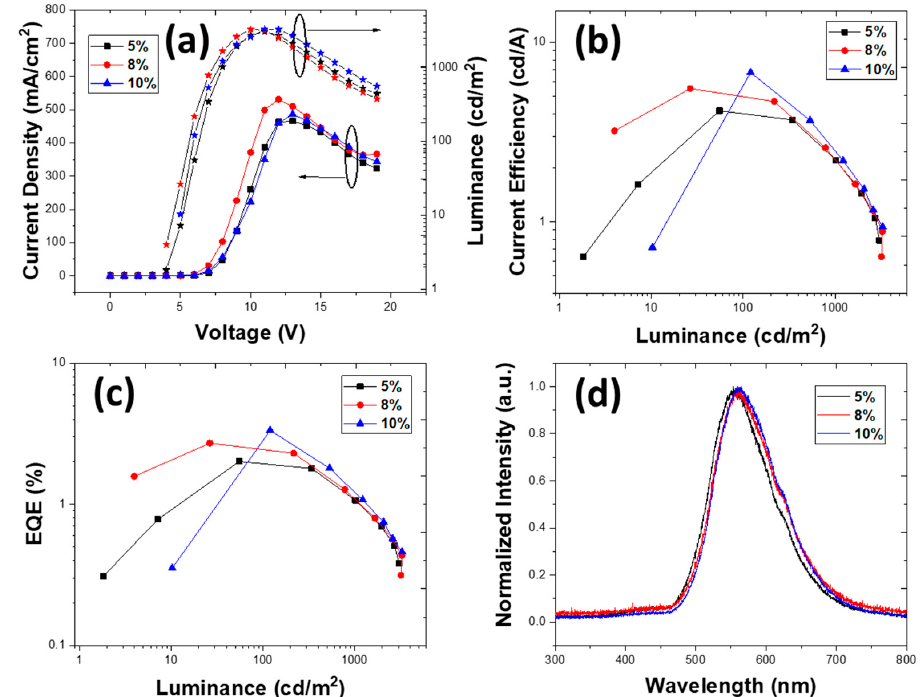
Figure 6. Device characteristics for structure ITO / PEDOT:PSS (40 nm) / PVK:OXD-7:TXO-TPA (x wt.%) (40 nm) / TmPyPb (40 nm) / LiF (1 nm) / Al (100 nm) deposited from dichlorobenzene. ( a ) Current density vs. voltage vs. luminance, ( b ) current e ffi ciency vs. luminance, ( c ) EQE vs. luminance, and ( d ) electroluminescence spectra for 5, 8, and 10 wt.% (at 14